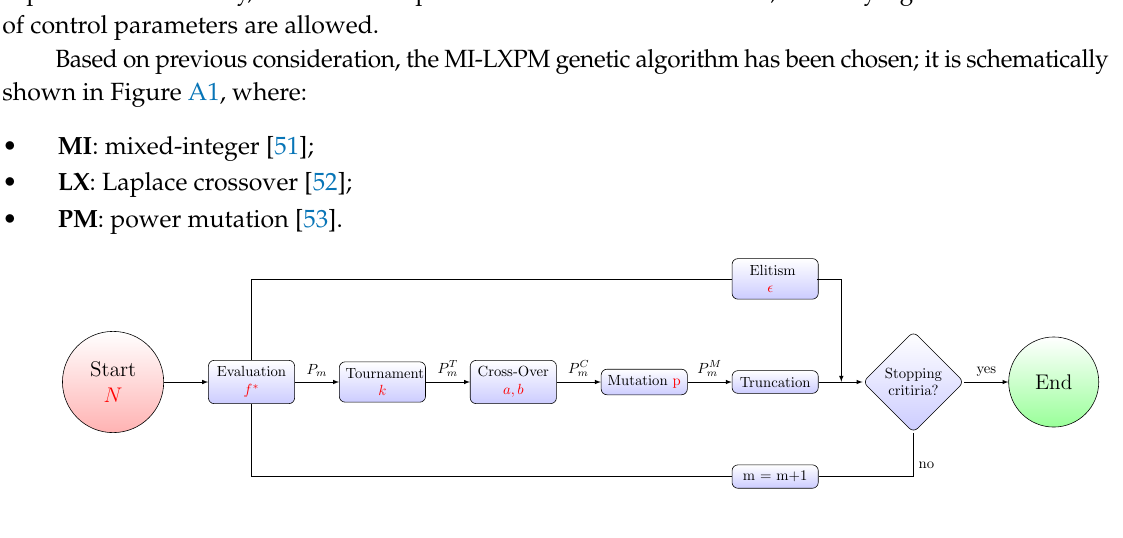
Figure A1. Flowchart of the MI-LXPM genetic algorithm. All phases are described in detail in Appendixes A.1–A.6. Major tuning parameters of the genetic algorithm are shown in red in the flow chart, and summarised in Table